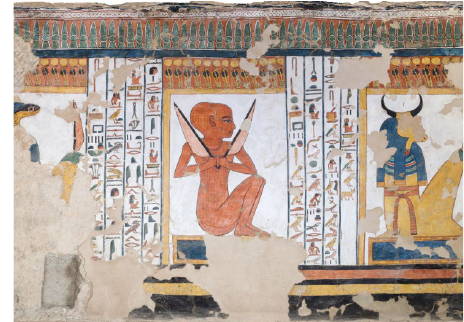
Figure 1. A detail of an orthophoto from the 2017 survey of the wall paintings in Chamber K of the Tomb of Nefertari (Credit: Carleton Immersive Media Studio; Carleton University. © J. Paul Getty Trust).